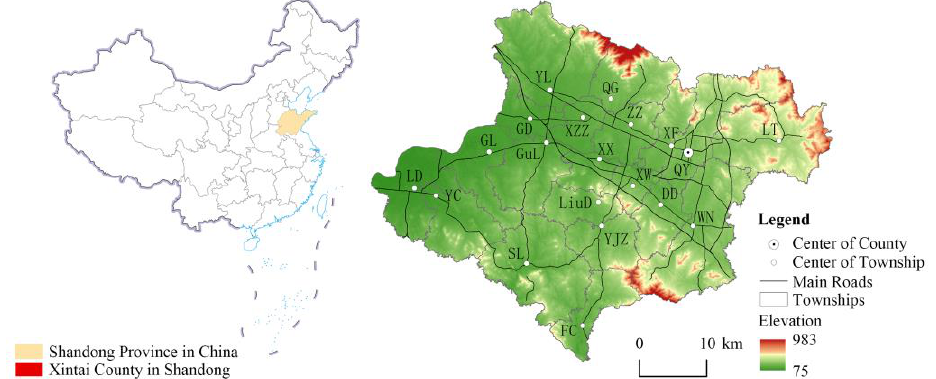
Figure 2. Overview of the study area.